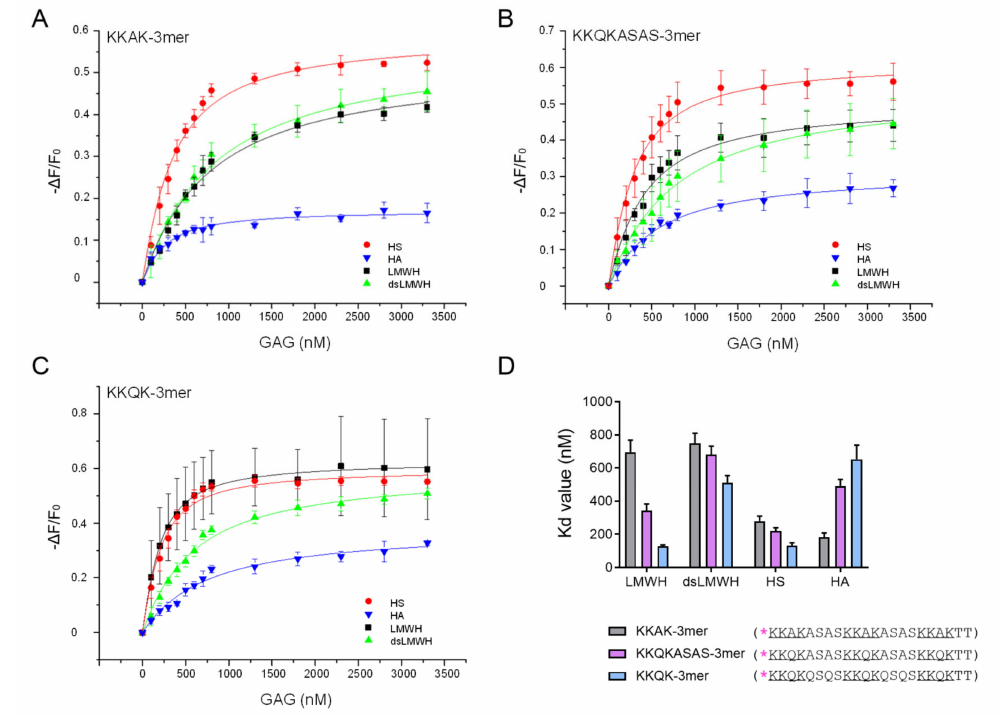
Figure 3. Gln residues in both GAG-binding motifs and linker sequences increase trimer peptide binding affinity for (ds)LMWH and HS, but not HA. Isothermal fluorescence titration (IFT) measure- ments were performed to study the interactions between TAMRA-labeled trimer peptides (KKAK-, KKQKASAS- and KKQK-3mer) and GAGs ((ds)LMWH, HS and HA). ( A – C ) Binding isotherms for the KKAK-3mer ( A ), KKQKASAS-3mer ( B ) and KKQK-3mer ( C ) are displayed. The change in fluorescence intensity ( ∆ F) divided by the intrinsic fluorescence of the peptide (F 0 ) is shown on the y-axis. ∆ F is calculated by subtracting F 0 from the fluorescence emission measured at a certain GAG concentration (F). The concentration of the added GAG is shown on the x-axis. Data points represent mean ± SEM ( n = 3). ( D ) K d values ( ± SD) that are derived from the binding isotherms in ( A – C ) are visualized in the bar plot. TAMRA-labeling is indicated with [*] and the GAG-binding motifs are underlined in the amino acid sequences of the